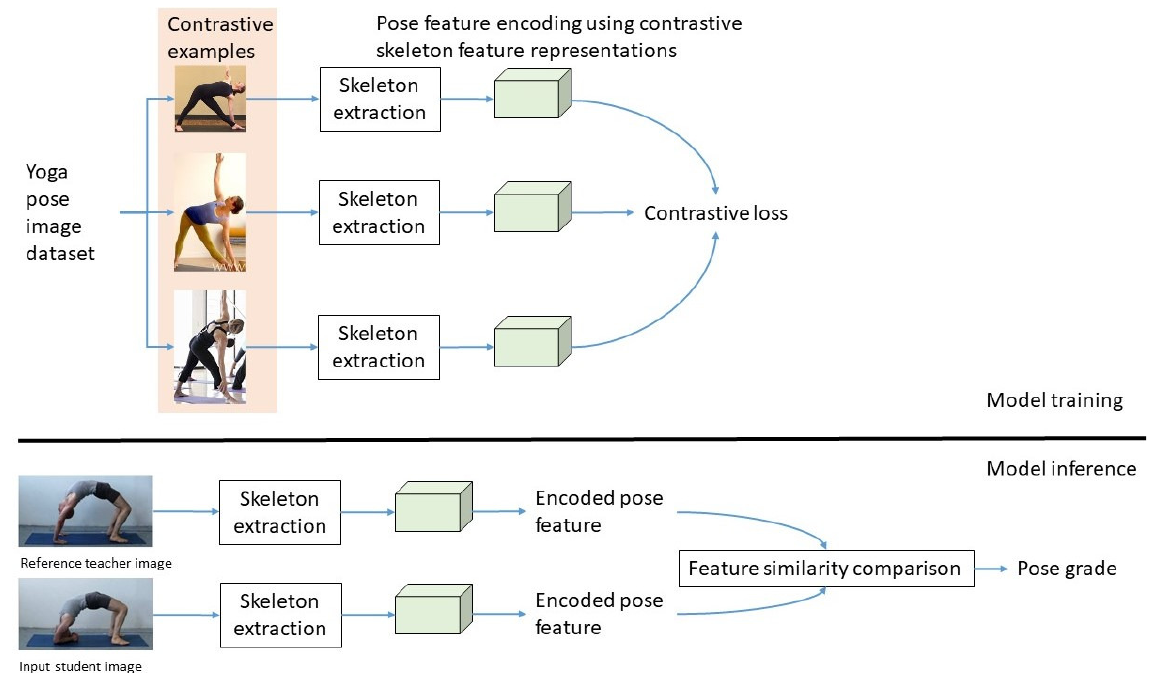
Figure 1. A conceptual overview of the proposed yoga pose grading framework. The model training process consists of three key components: (i) construction of contrastive examples, (ii) skeleton extraction, (iii) pose feature encoding using contrastive skeleton feature representations. The model inference process consists of (i) skeleton extraction, (ii) pose feature encoder, and (iii) feature similarity comparison. Both skeleton extraction and pose feature encoder are the same in these two processes.